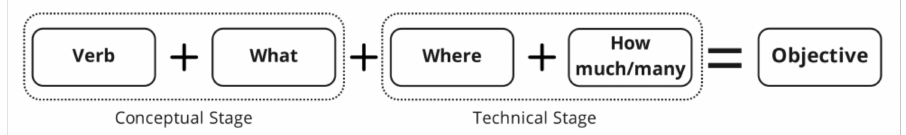
Figure 3. A simple framework to structure client and project